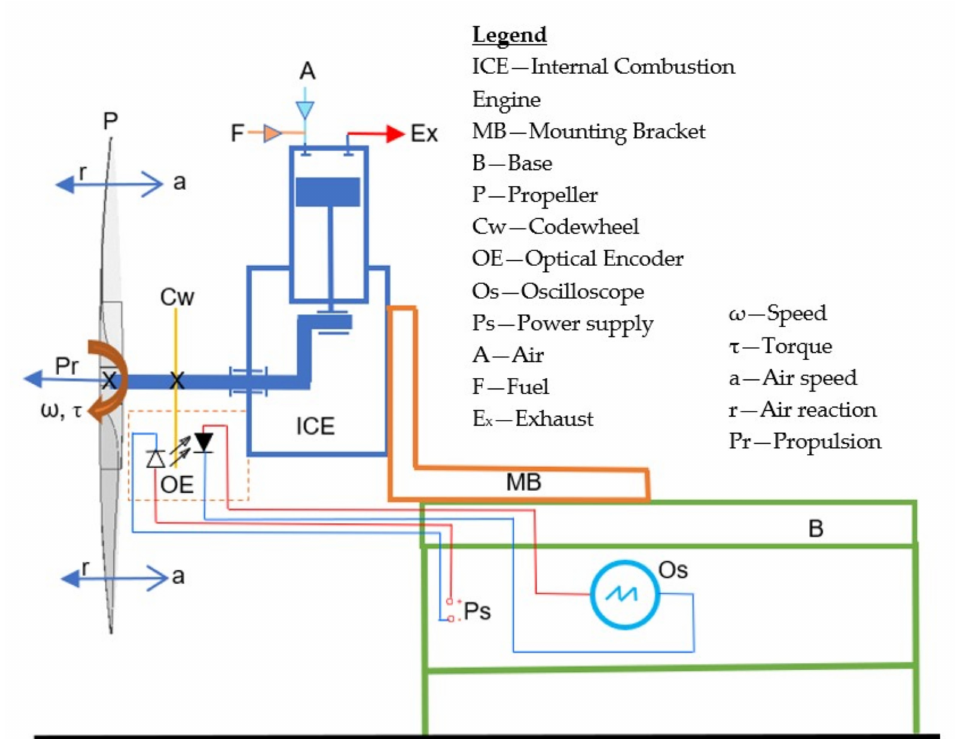
Figure 7. Experimental setup schematic